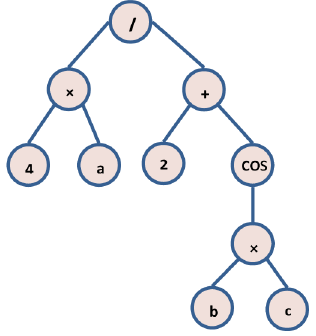
Fig. 1. Illustration of a GP model in a tree-like structure Fig. 2. Typical illustration of an